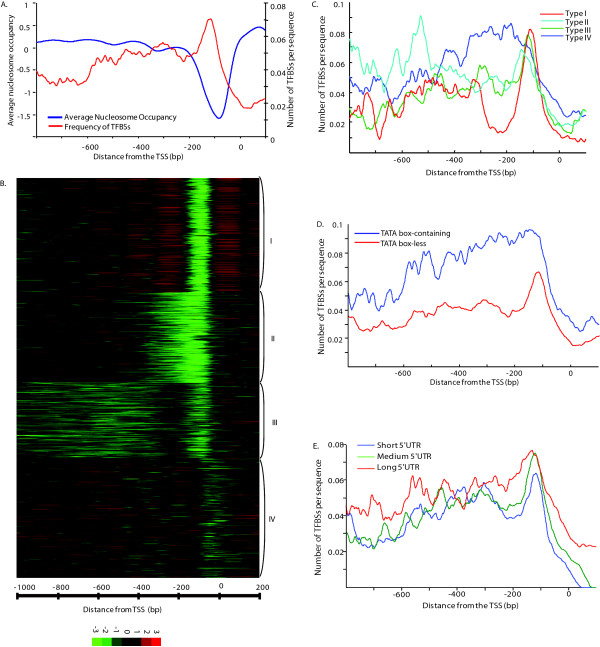
The effects of promoter architecture features on the TFBS distribution. (A) Strong negative correlation between the TFBS frequency and the genome-wide average of nucleosome occupancy in the ~200 bp region upstream of the TSS. The intergenic regions were aligned with reference to TSS. (B) The yeast genes were clustered into four groups by k-means clustering based on a 1201 bp region surrounding the TSS. (C) The frequency distributions of TFBSs relative to the TSS in four clusters of genes with diverse nucleosome occupancy patterns. The figure is presented in the same way as Figure 1A. (D) The TFBS distribution differs between TATA box-containing and TATA box-less genes. The TATA box-containing genes have more broadly distributed TFBSs and higher TFBS frequency in the promoter region. (E) The distributions of TFBSs relative to the TSS in three categories of 5'UTR length: short, medium and long. The long 5'UTR genes have more broadly distributed TFBSs and a higher TFBS frequency in the promoter region.